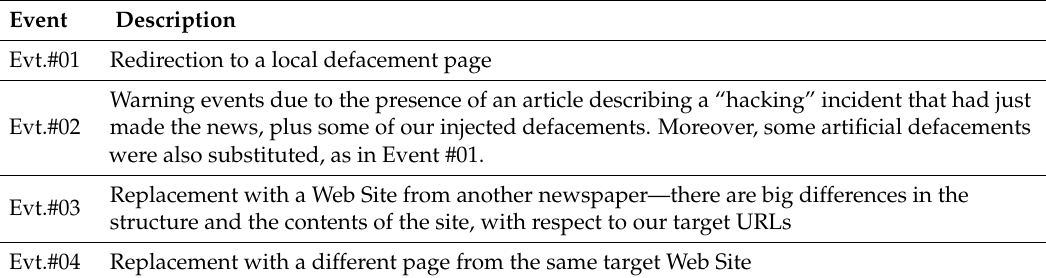
Figure 7. Aggregated evaluation and relevant events (newspaper scenario). Table 2. Major events in the newspaper